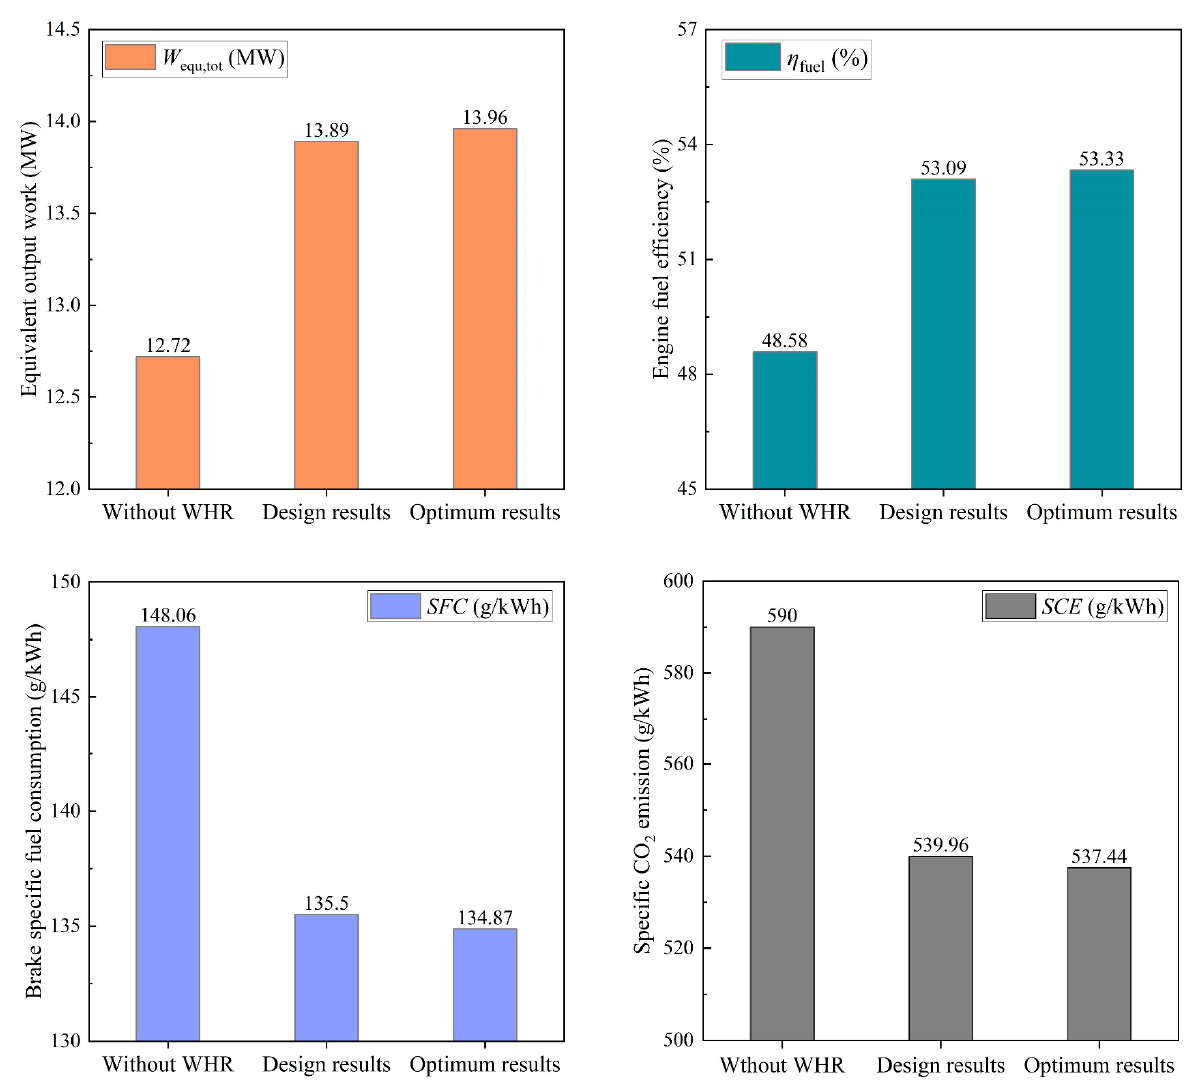
Figure 10. Genetic algorithm for optimizing the engine with WHR system.